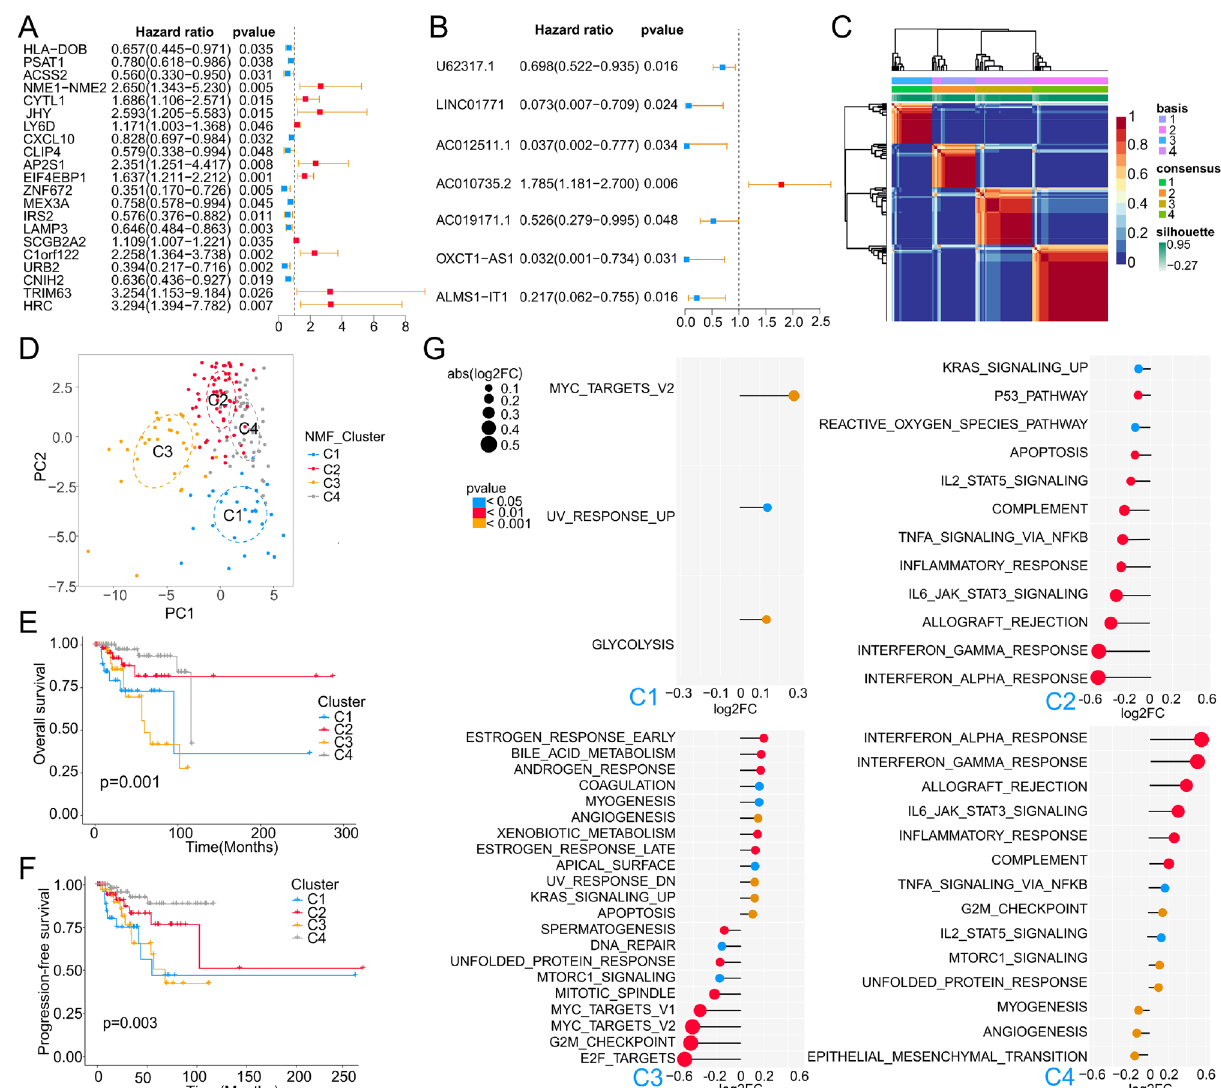
Figure 4. Identification of TNBC molecular subtype. ( A , B ) Univariate Cox analysis of mRNAs and lncRNAs, respectively. ( C ) Unsupervised clustering analysis of the TCGA-TNBC specimens using non-negative matrix factorization (NMF) and 23 BEZ235 response-related genes. An optimal rank of 4 was selected based on high cophenetic and silhouette coefficients (see Fig. S6). shown is the NMF matrix at rank of 4, and the subgroup assignments derived from this cluster solution are color-coded at top. ( D ) Principal component analysis (PCA) of TCGA-TNBC specimens using 23 BEZ235 response-related genes. ( E , F ) Kaplan–Meier overall survival (OS) curve and progression-free survival (PFS) curve for TCGA-TNBC patients of different clusters. ( G ) Based on the Hallmark gene set, GSVA analysis was utilized to mine the functional characteristics of each cluster relative to the other 3